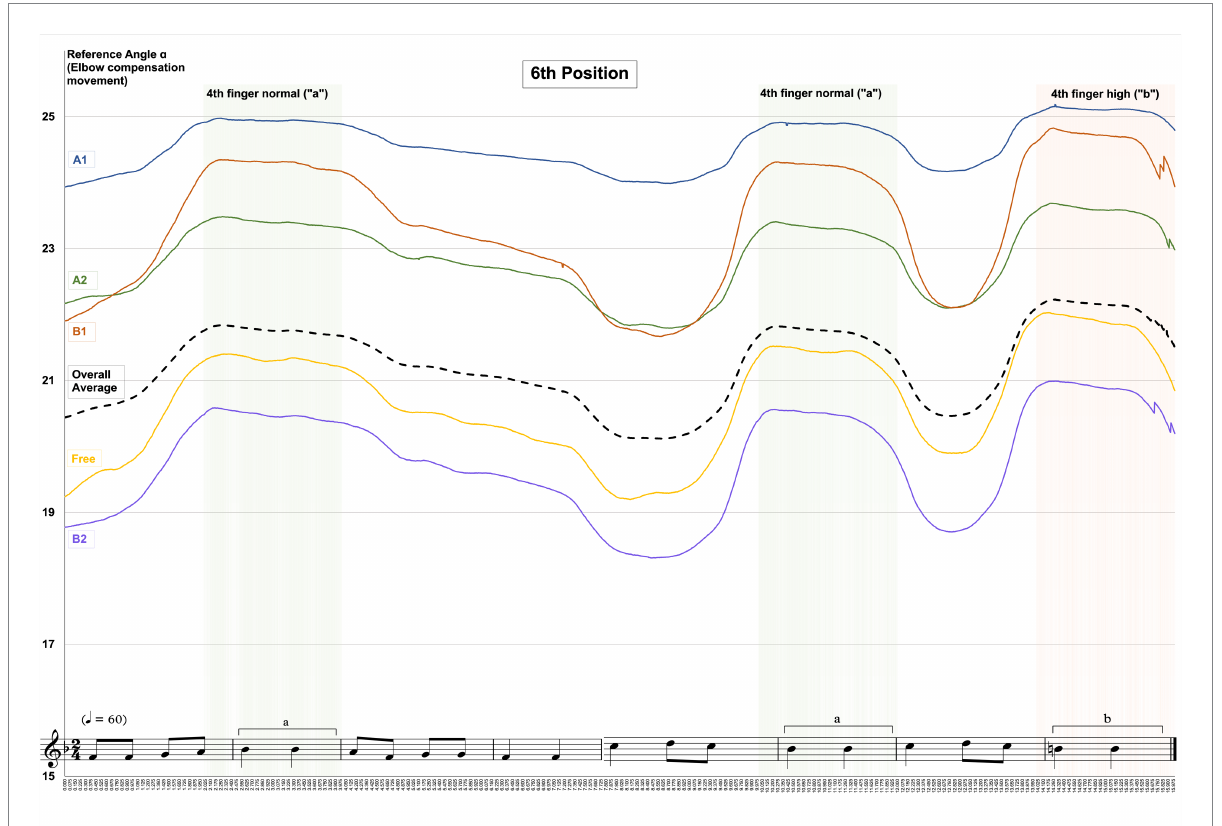
FIGURE 7 Changes in Reference Angle α by instrument position and overall mean when playing in sixth hand